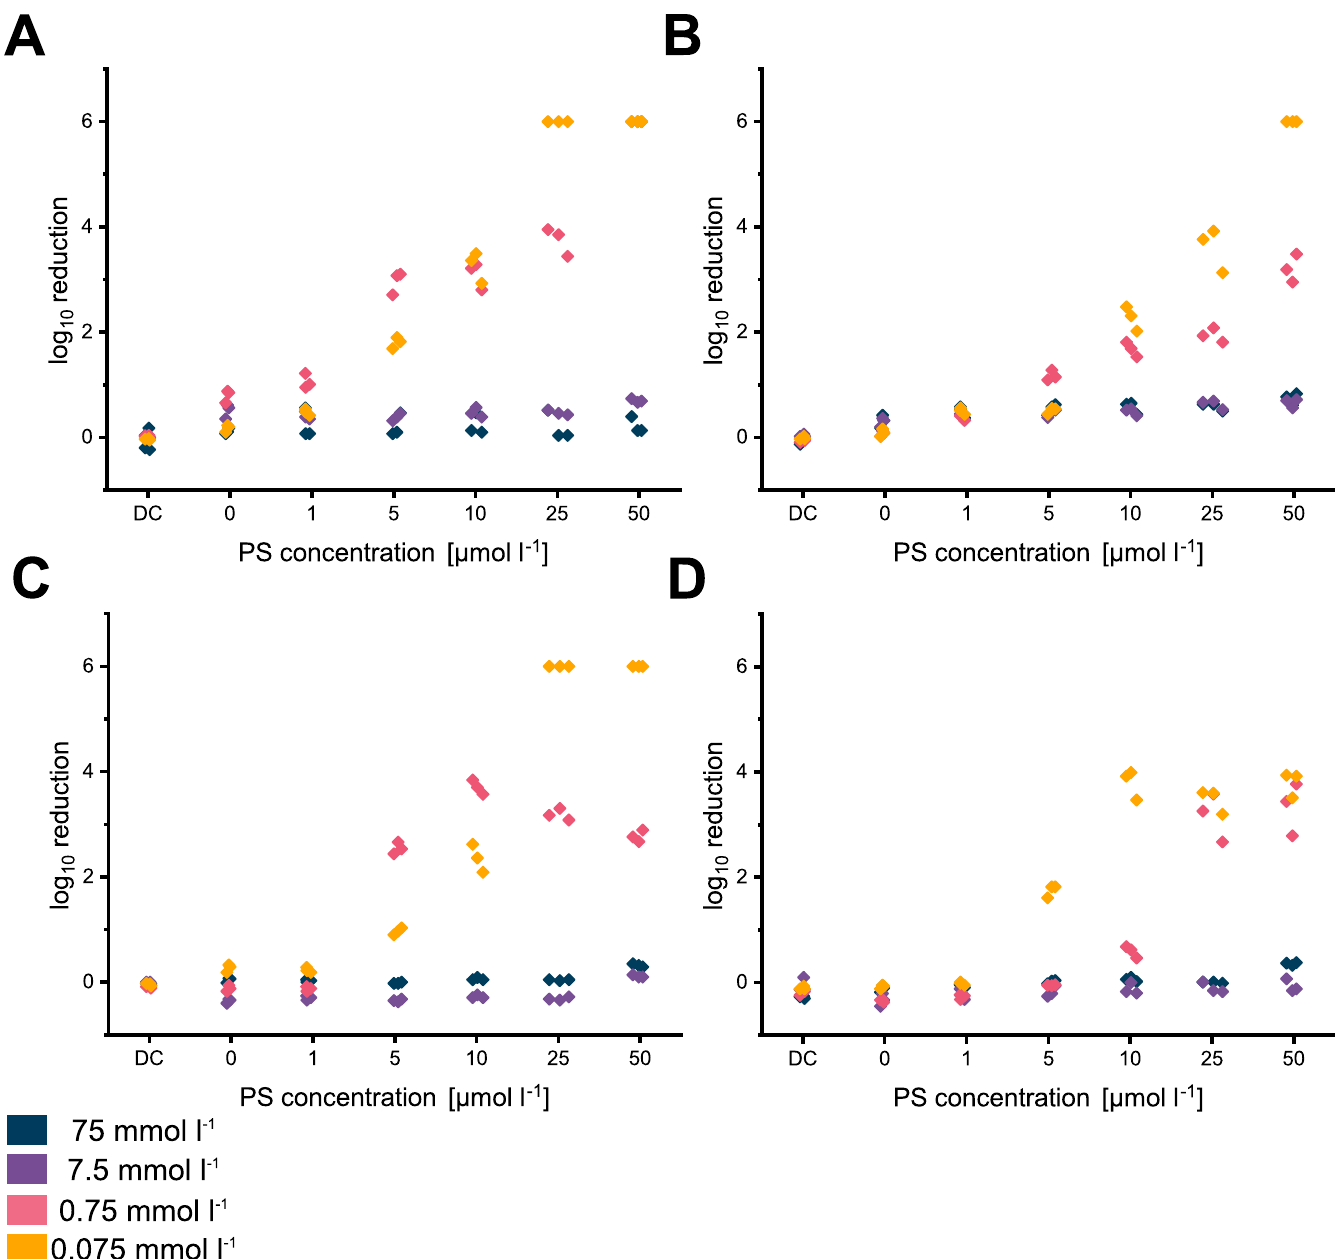
Fig 6. Logarithmic inactivation for S . aureus data obtained for each experiment displayed as scatter plot. (A) shows results for sodium phosphate and FLASH-02a, (B) displays the results for sodium carbonate and FLASH-02a. Obtained values for FLASH-06a are displayed in (C) for sodium phosphate and (D) for sodium carbonate. Y axes indicate the decadic logarithmic reduction and x axes indicate the PS concentration in μ mol l -1 or the dark control (DC). Different colors of the dots indicate the various sodium carbonate or sodium phosphate concentrations.